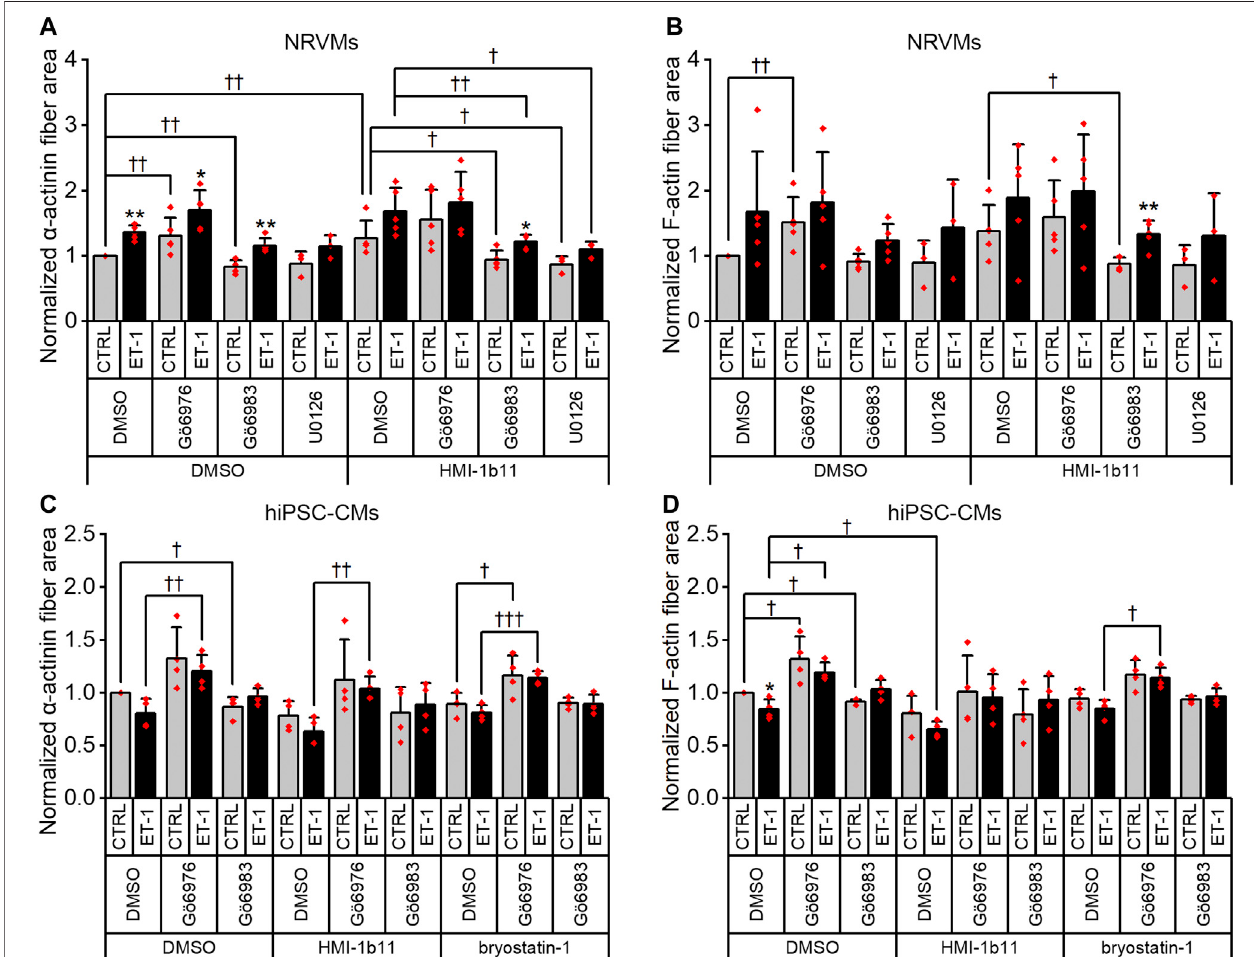
FIGURE8| Effects ofendothelin-1 (ET-1) andpharmacological PKCmodulationon theareaof α -actinin and F-actin fi bers incardiomyocytes.Theareaof α -actinin (A,C) and F-actin fi bers (B,D) in NRVMs and in hiPSC-CMs was measured after 48 h exposure to PKC activators (10 µM HMI-1b11 and 10 nM bryostatin-1),